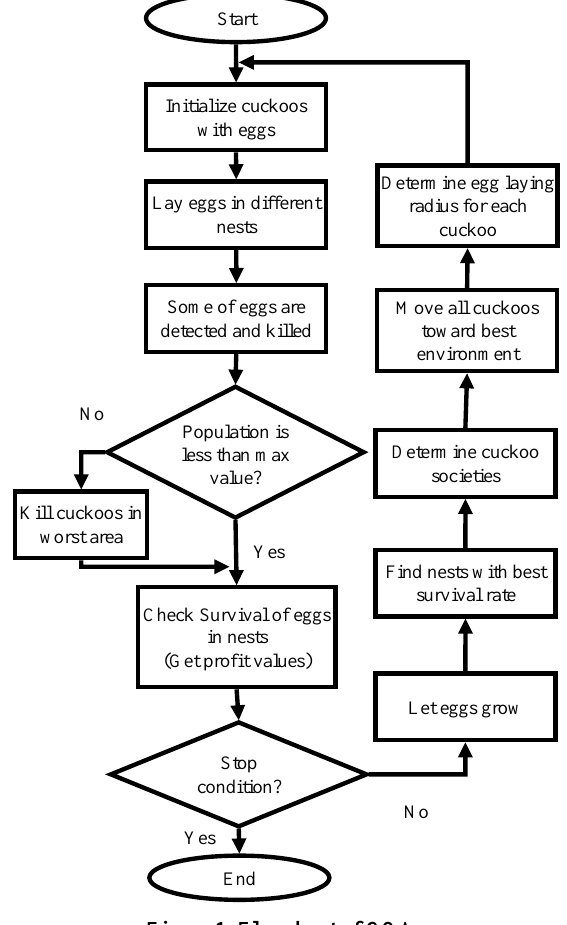
Figure 1. Flowchart of COA.